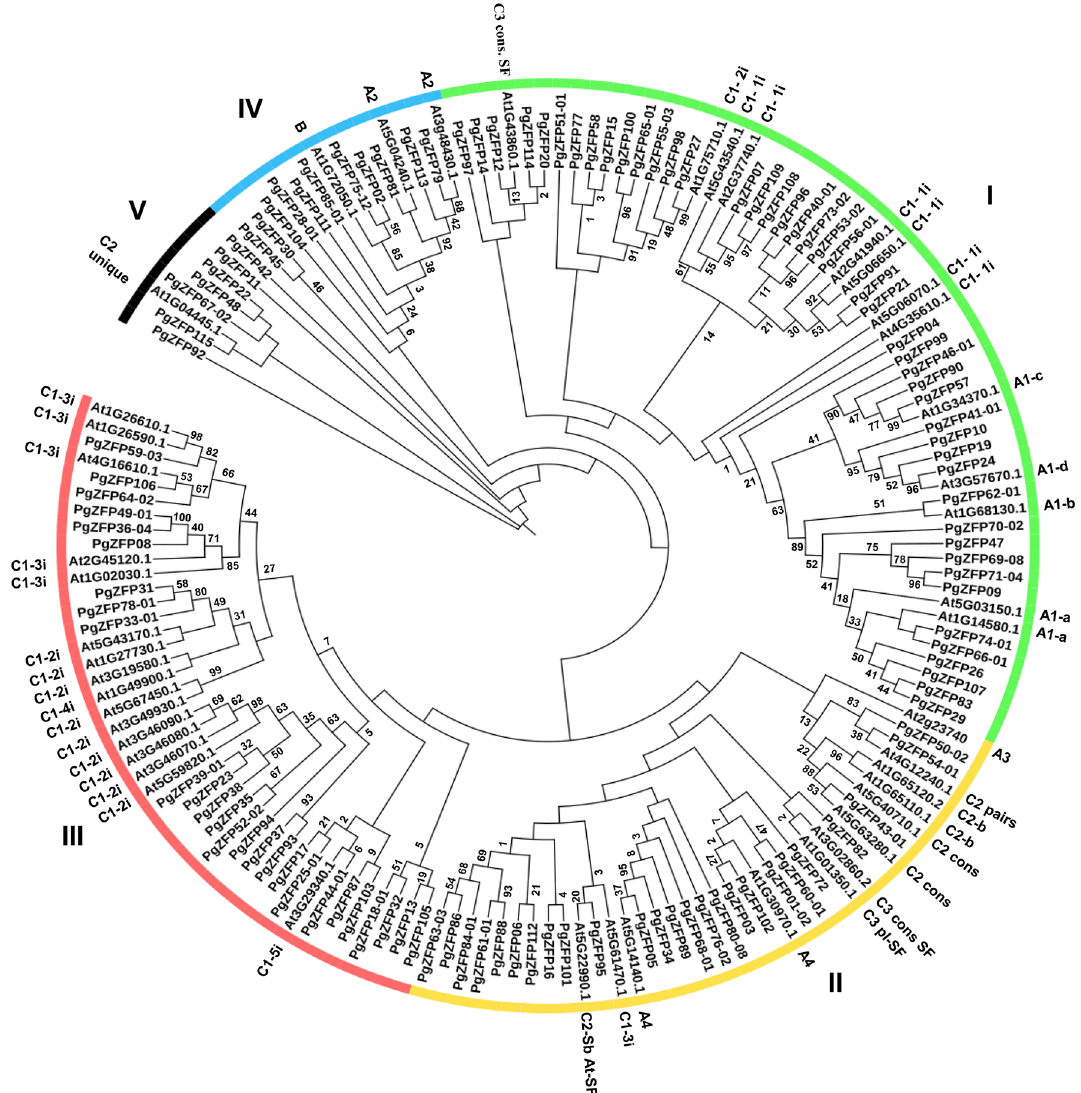
Figure 2. Phylogeny of the PgZFP gene family. The phylogenetic tree of the PgZFP gene family was constructed using all 115 PgZFP genes and the C2H2-ZFP genes of Arabidopsis thaliana ( At ) as outgroup. The subfamilies of the PgZFP gene family are indicated by I, II, III, IV, and V . The phylogenetic tree was constructed using the maximum-likelihood (ML) method with 1,000 bootstrap replications. The number nearby each cluster indicates the bootstrap confidence of the cluster in percentage